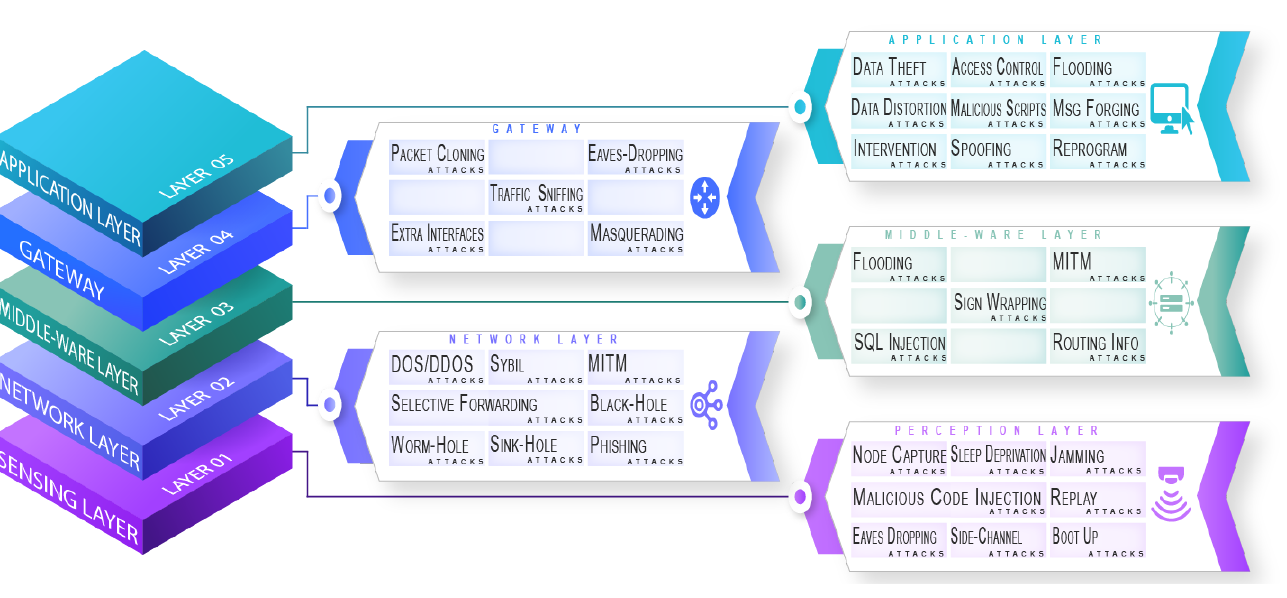
Figure 1. Taxonomy of attacks and threats attempted on IoT